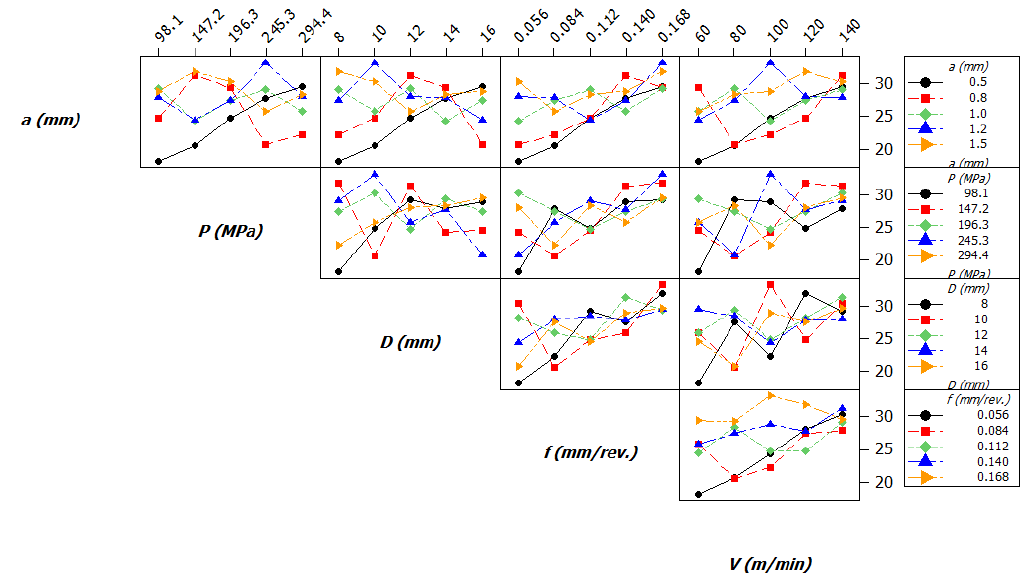
Figure 6. The interactive effects of machining parameters on energy efficiency.